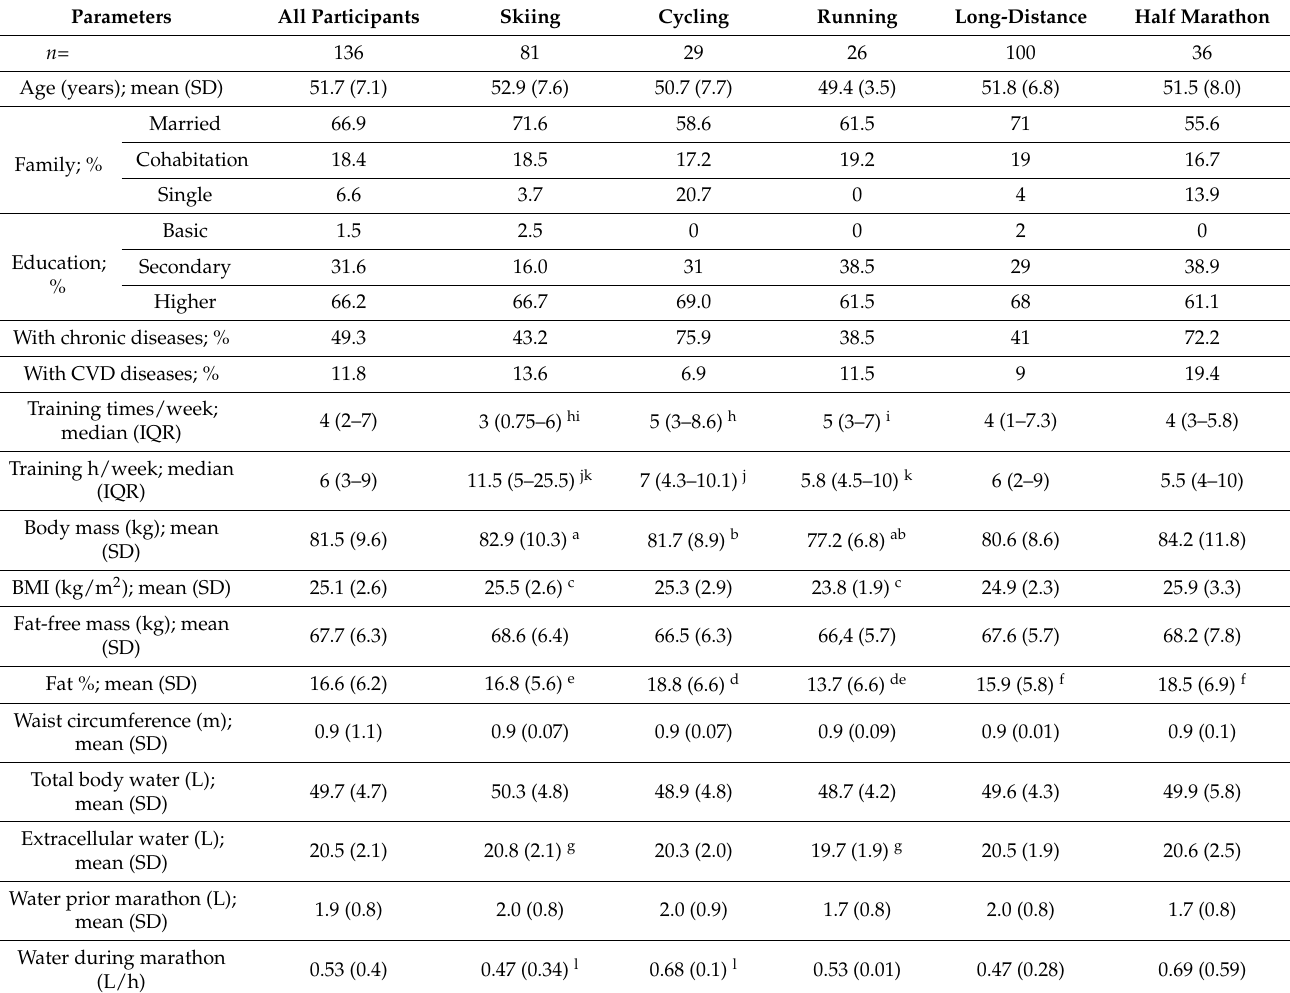
Parameters All Participants Skiing Cycling Running Long-Distance Half